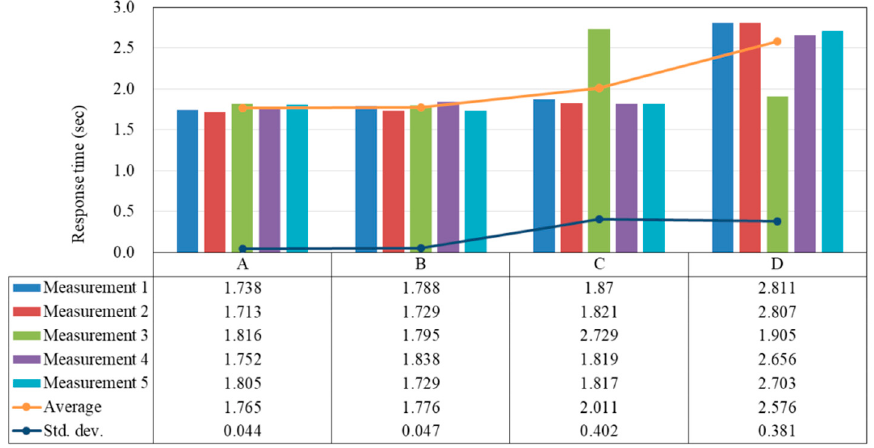
Figure 10. Time taken for the Mobile App to receive the acknowledgement message in Experiment 2 (s).